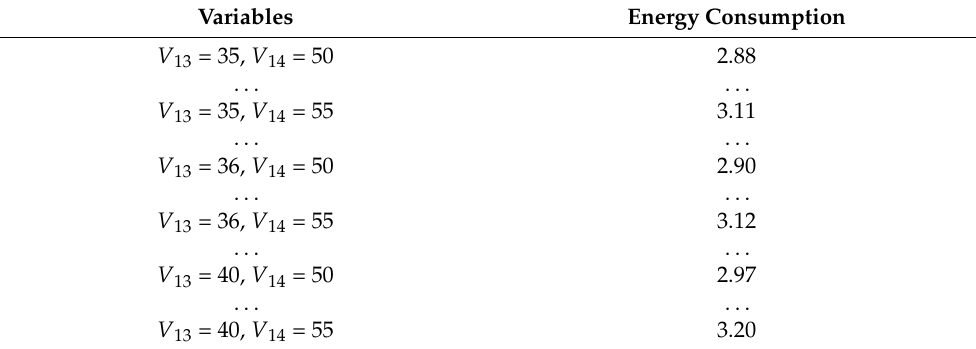
Table 6. Simulations of changes in energy consumption for the